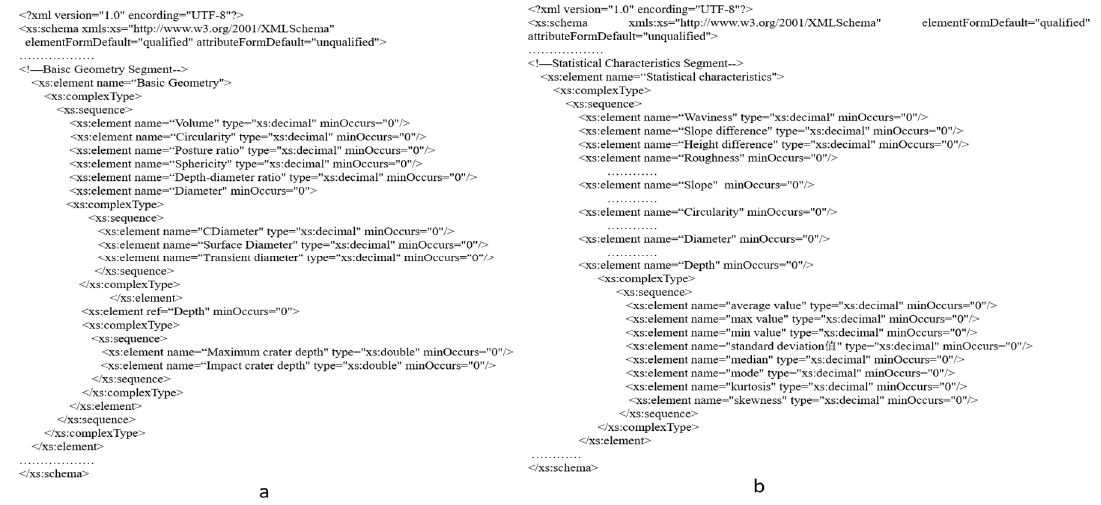
Figure 15. Fragments of the XML scheme for the usage of indices. ( a ) Basic Geometry; ( b ) Statistical characteristics.